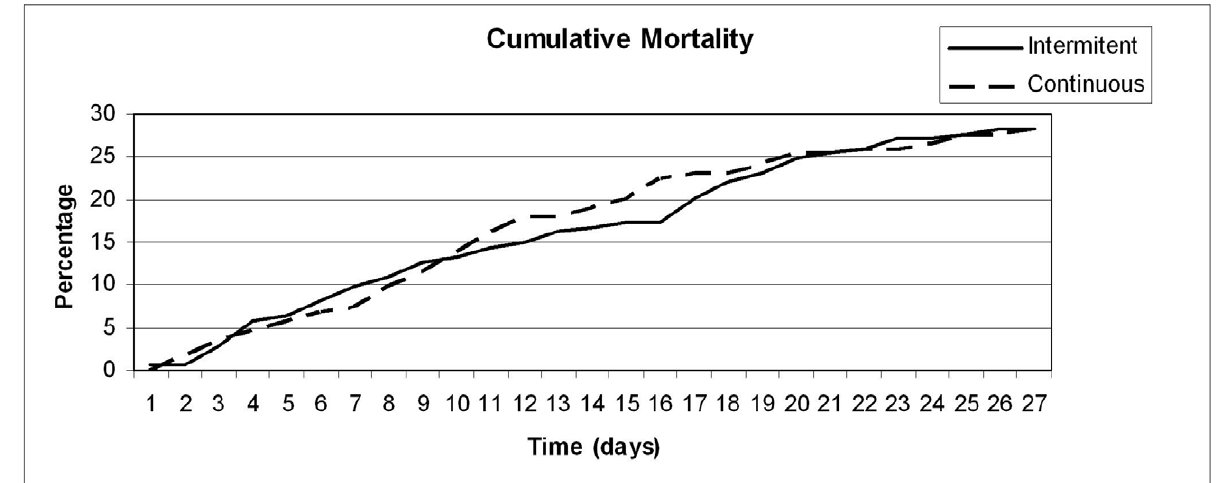
Figure 1. Cumulative mortality in the first 28 days after starting piperacillin/tazobactam therapy either in continuous infusion (dashed line) or 30 min bolus dosing (solid line).